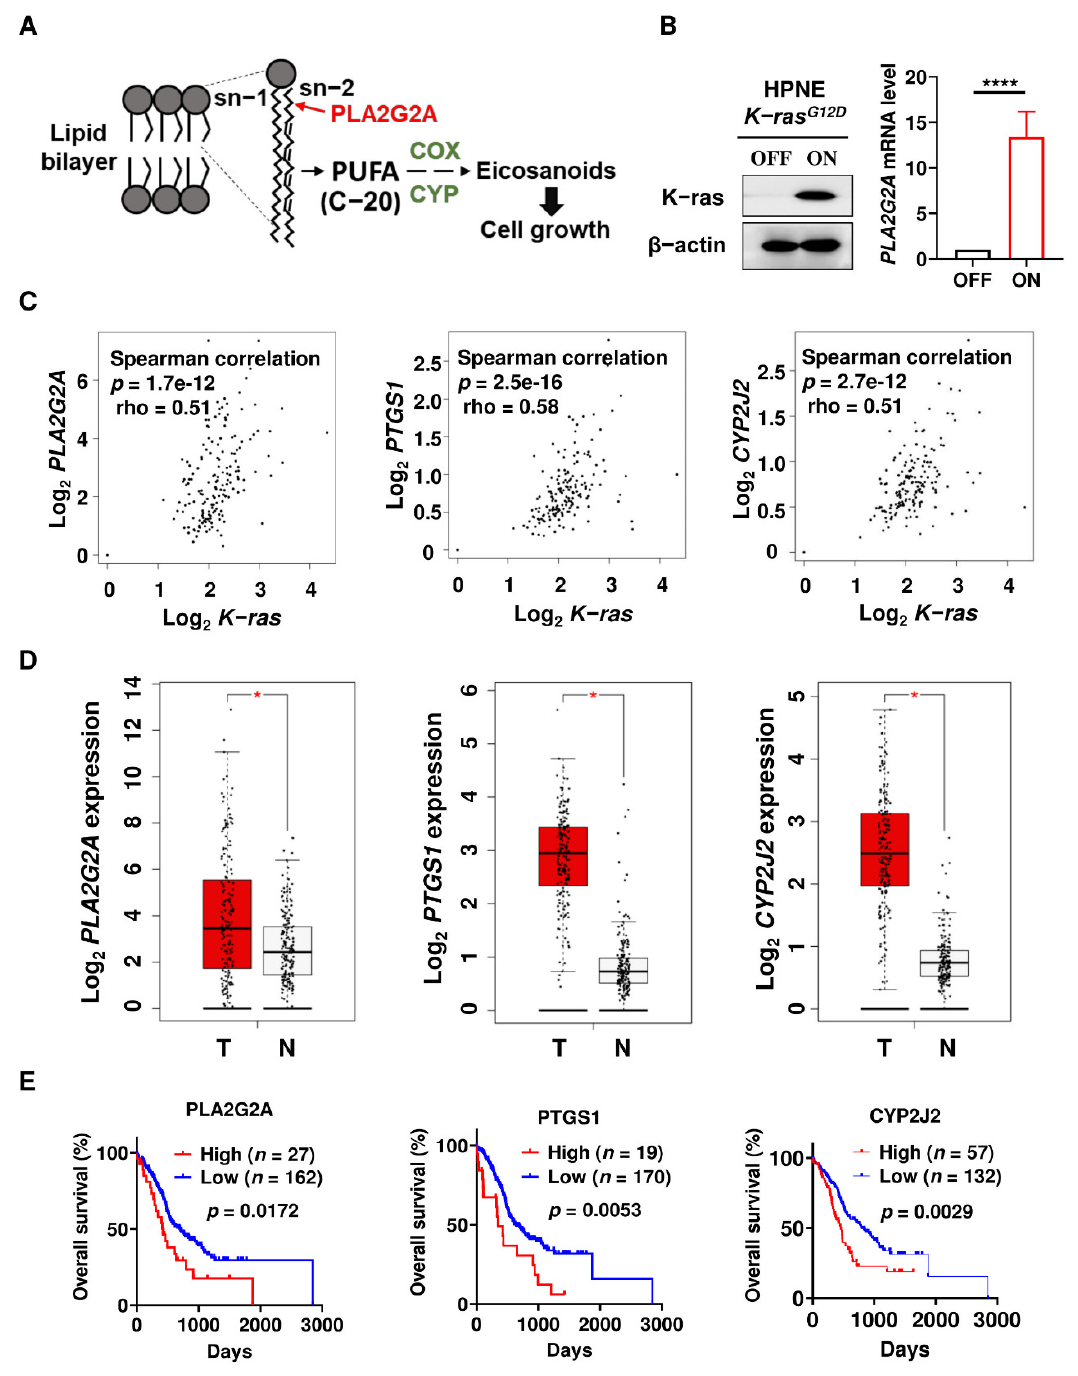
Figure 1. Activation of mutant K-ras G12D induces PLA2G2A expression and the relationship between PLA2G2A expression and clinical outcomes of PDAC patients. ( A ) Schematic illustration of the PLA2G2A-mediated pathway with a release of PUFA for synthesis of eicosanoids.